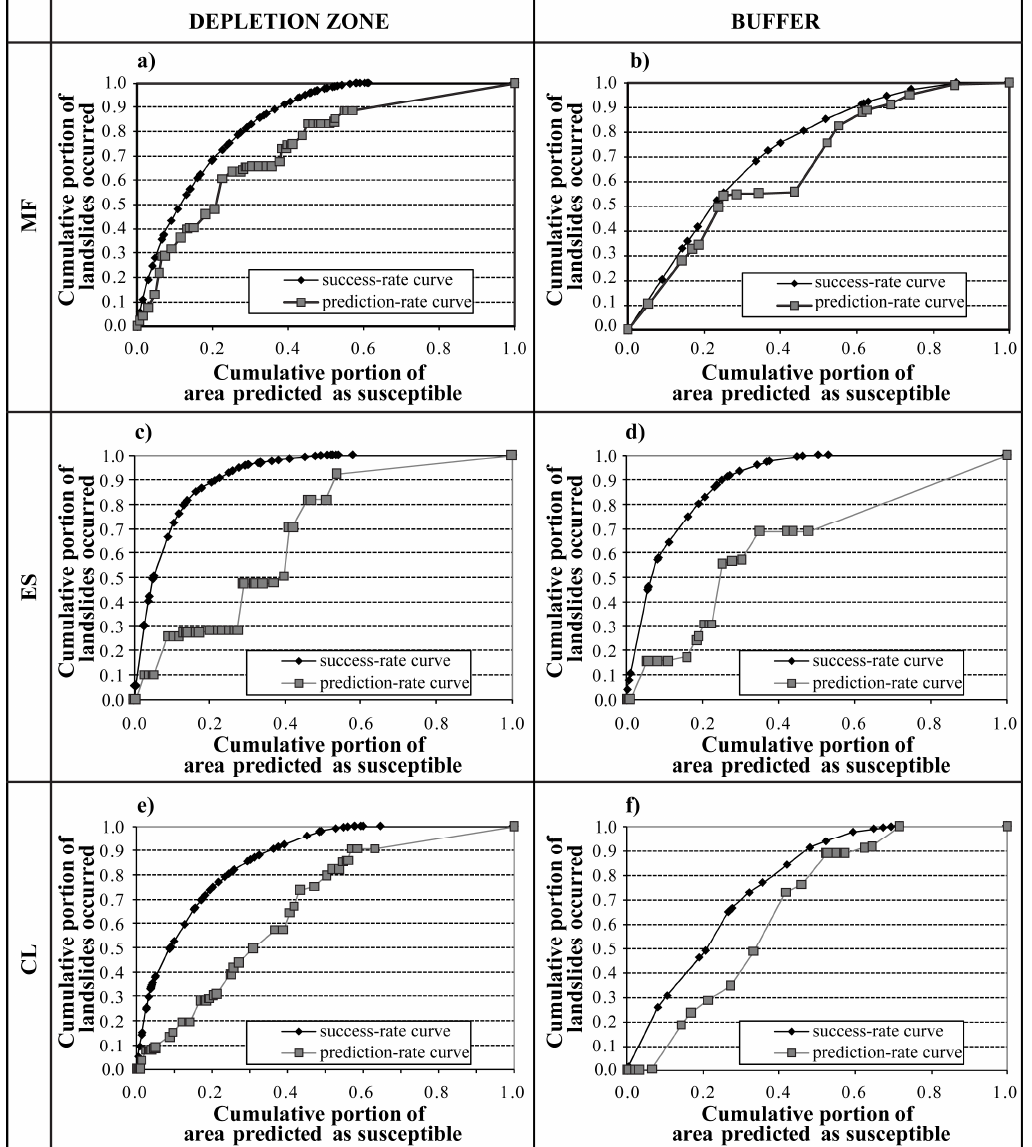
Figure 10: Prediction- and success-rate curves for mud flows, earth slumps and complex landslides, generated using the procedure proposed by Chung and Fabbri (2003) adapted for vector datasets.